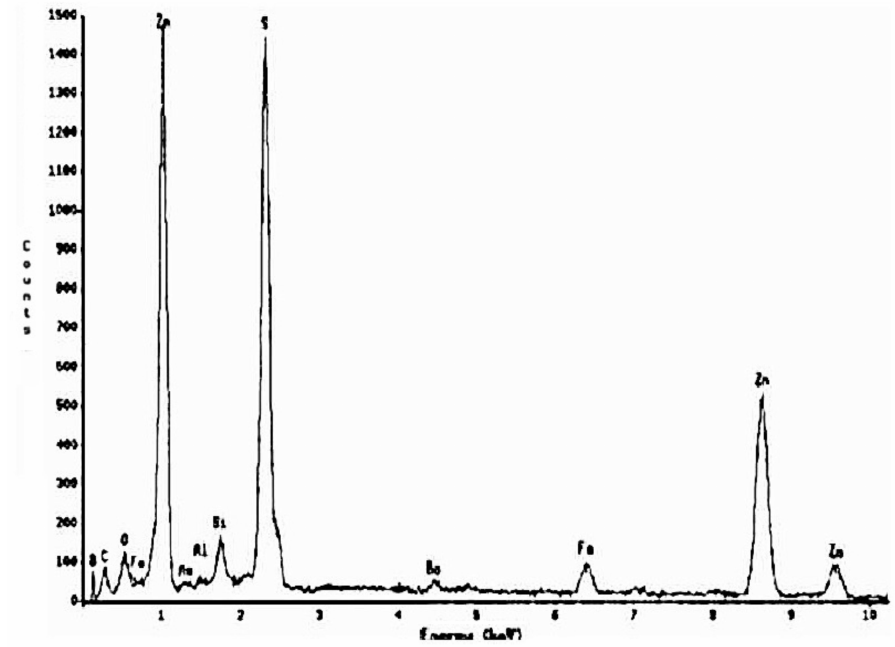
Figure 15. Microanalysis of sphalerite particles shown in Figure 13, after electrolysis. On the other hand, the chronoamperometric analyses (Figure 16) show an initial tran- sition time in which the current density is used for charging the double layer. Subsequently, a slight potential variation in function of time is observed, reaching a constant potential difference over time.